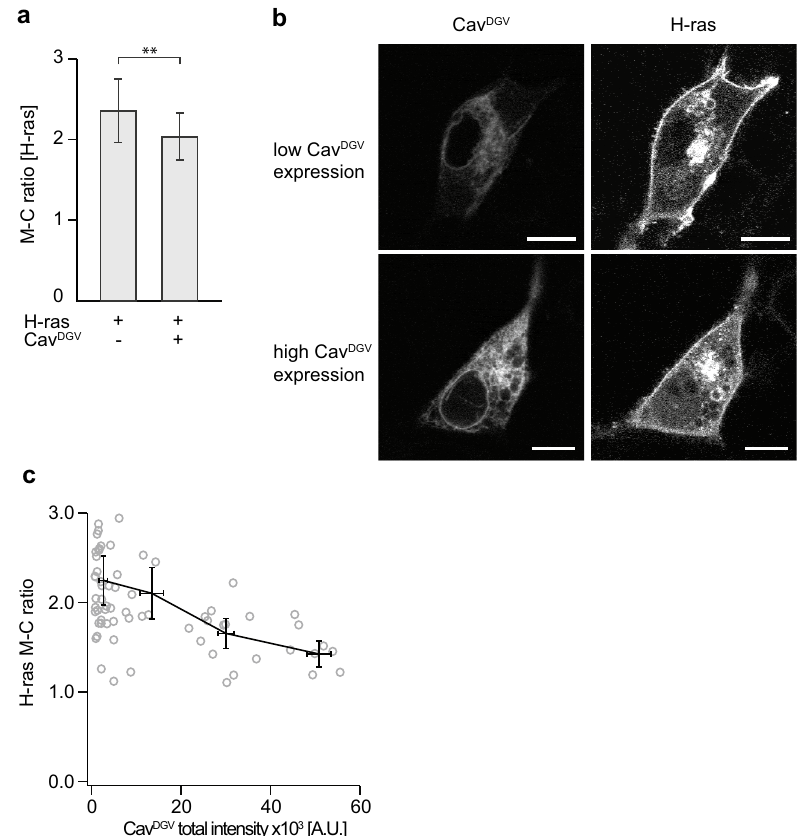
Figure 5. Increasing CavDGV expression causes relocalization of H-ras from PM to cytoplasm. ( a ) Plot shows comparison of M-C ratio of RFP-H-ras G12V (H-ras) in NIH 3T3 cells co-expressing RFP-H-ras G12V (H-ras) and GFP-CavDGV (CavDGV) ( n = 73), or expressing RFP-H-ras G12V (H-ras) alone ( n = 65). Error bars represent ± 0.5 SD. Stars indicate statistically significant differences (** p = 0.001–0.009; for exact p-values see Table S3). ( b ) Impact of GFP-CavDGV (CavDGV) expression level on subcellular localization of RFP- H-ras G12V (H-ras). Scale bar 10 μm. ( c ) Plot shows dependence of RFP-H-ras G12V (H-ras) M-C ratio on expression levels of GFP-CavDGV (CavDGV) from co-expression experiment in NIH 3T3 cells. M-C ratio was calculated as described in the materials and methods section. The expression levels of CavDGV was calculated by summing up the integrated intensity of the membrane and cytosol ROIs. Data was divided into four bins according to the expression level (0–8000, 8000–25,000, 25,000–40,000, 40,000–65,000 a.u.) and average M-C ratio with average expression level was represented by the black crosses. Error bars of these crosses represent the